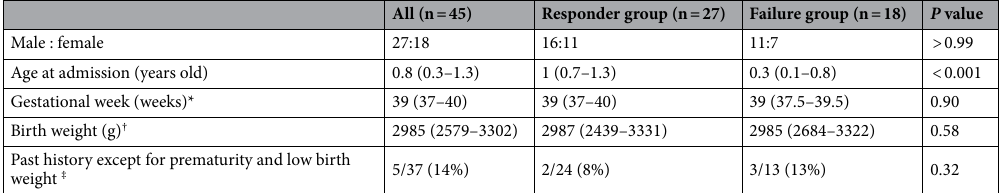
Table 1. Background between responder and failure group. Values are median + interquartile ranges, *; Evaluated 37 children who could collected the data of Gestational week, †; Evaluated 38 children who could collected the data of Birth weight, ‡; Evaluated 37 children who could collected the data of Gestational week and Birth weight.